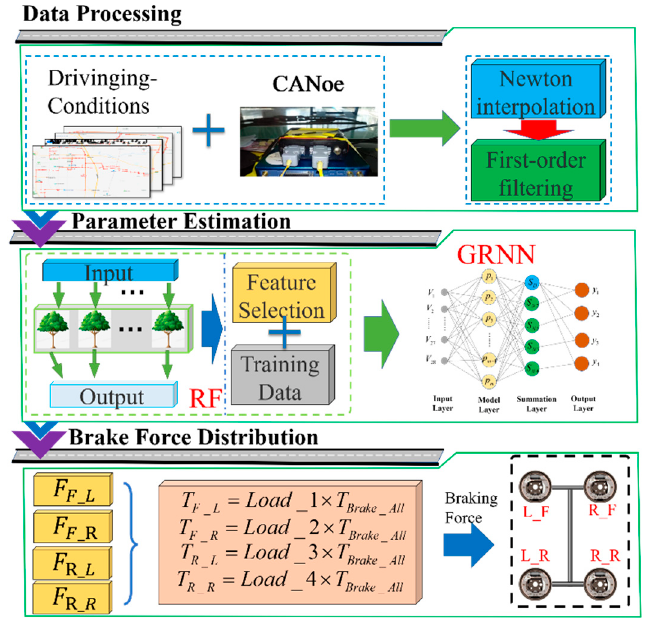
Figure 4. Parameter state observation and braking force distribution framework diagram. ( L _ F , R _ F , L _ R and R _ R are left-front wheel brake, right-front wheel brake, left-rear wheel brake and right-rear wheel brake, respectively).